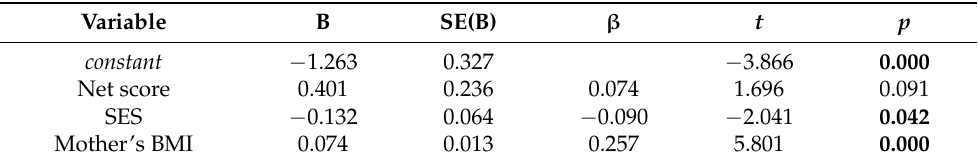
Table 3. The multiple linear regression result for BMI z score according to HDT outcome and